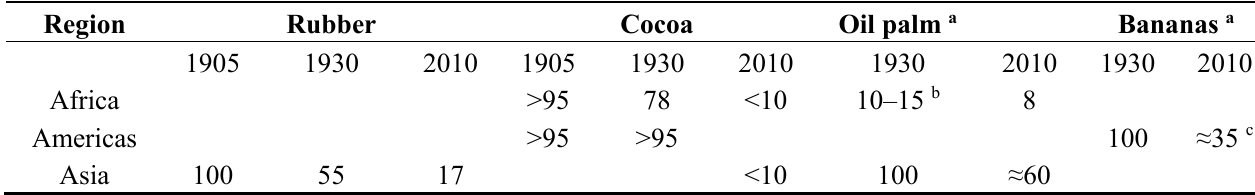
Table 3. Percent cultivated area of crops for exports under large plantations in a region at three different periods in time: 1905, 1930 & 2010 (Numbers in bold indicate the dominant exporting region at the